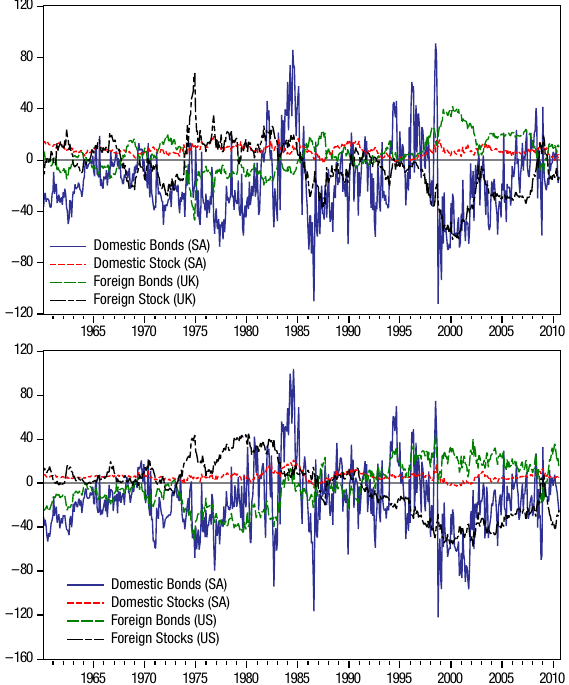
Fig. 2. The historical intertemporal hedging demands for domestic stocks, domestic bonds, foreign stocks and foreign bonds for investors in SA who can also invest in assets in the UK and in the